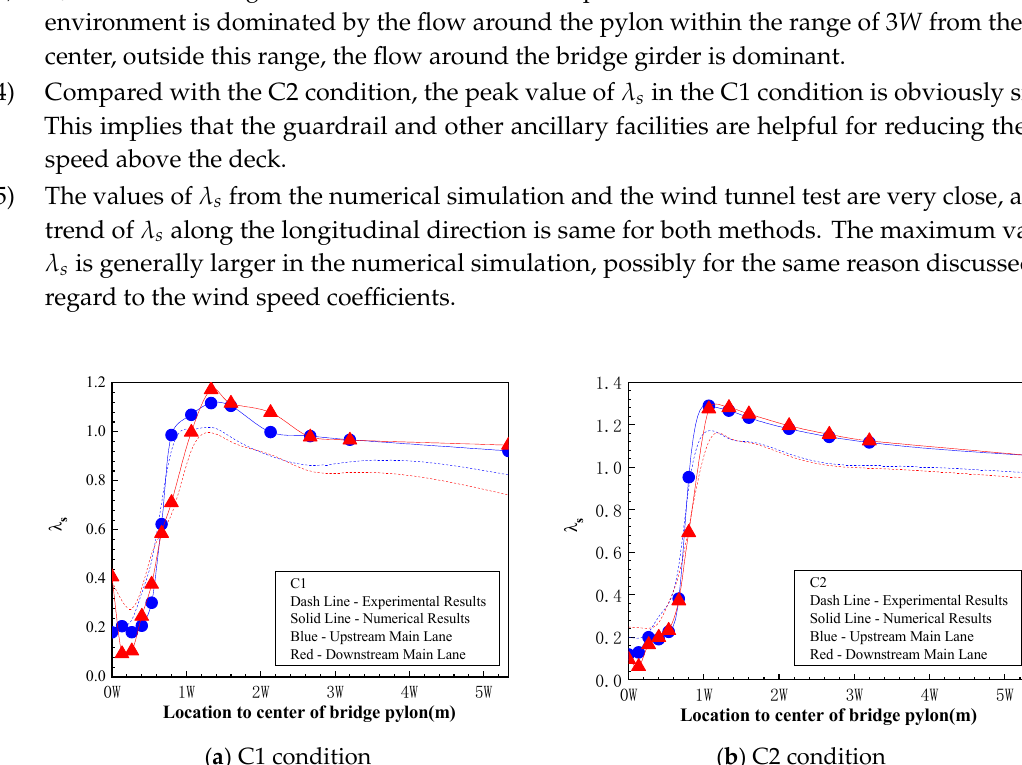
14 of 19 Figure 16. Wind speed coefficient at downstream main lane in C2 condition.